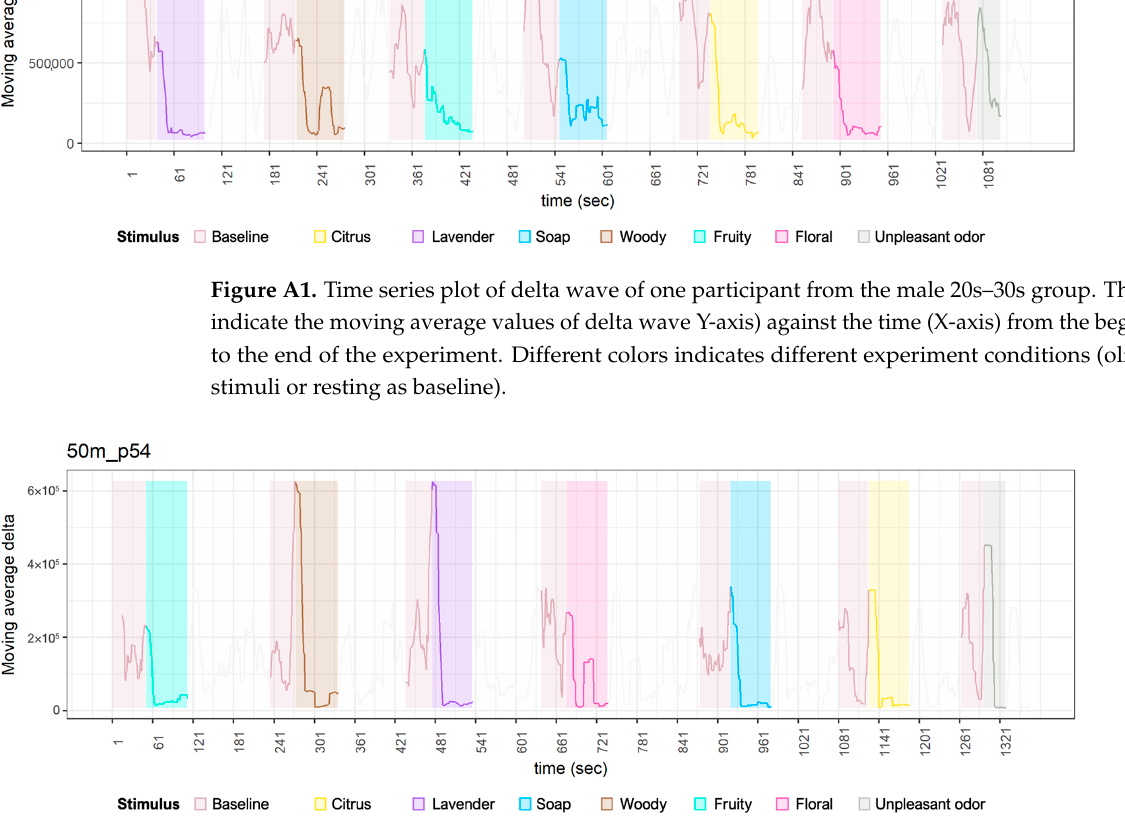
Figure A2. Time series plot of delta wave of one participant from the male 40s–50s group. The lines indicate the moving average values of delta wave Y-axis) against the time (X-axis) from the beginning to the end of the experiment. Different colors indicates different experiment conditions (olfactory stimuli or resting as baseline).